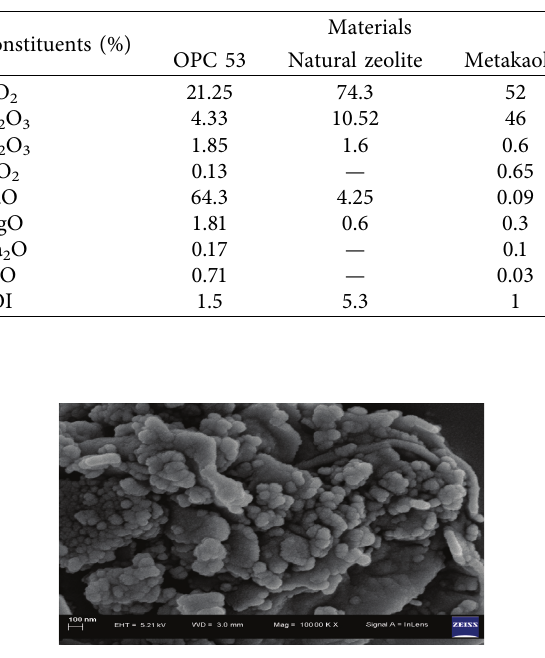
Figure 1: Scanning electron microscopy (SEM) of natural zeolite.